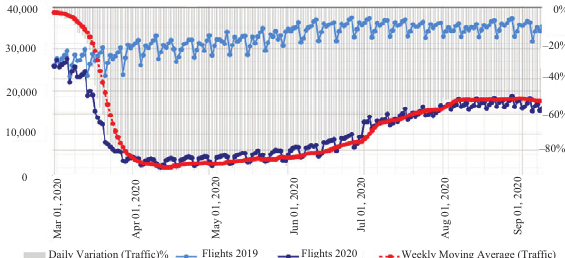
Figure 2. Evolution of flights in Europe from March, 2020 to